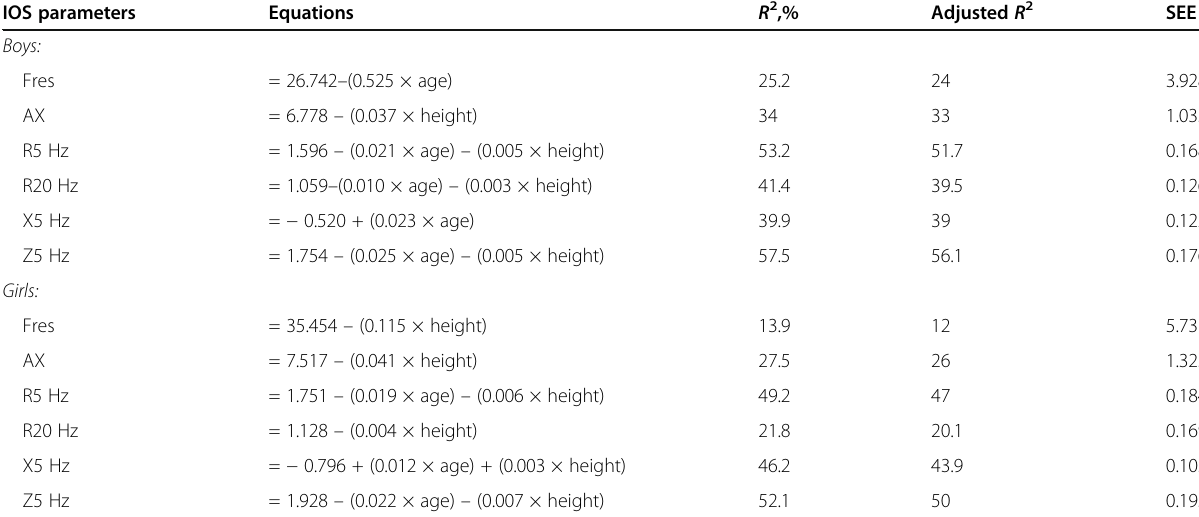
Table 5 Respiratory system reference equations obtained by the impulse oscillometry system for boys and girls IOS parameters Equations R 2 ,% Adjusted R 2